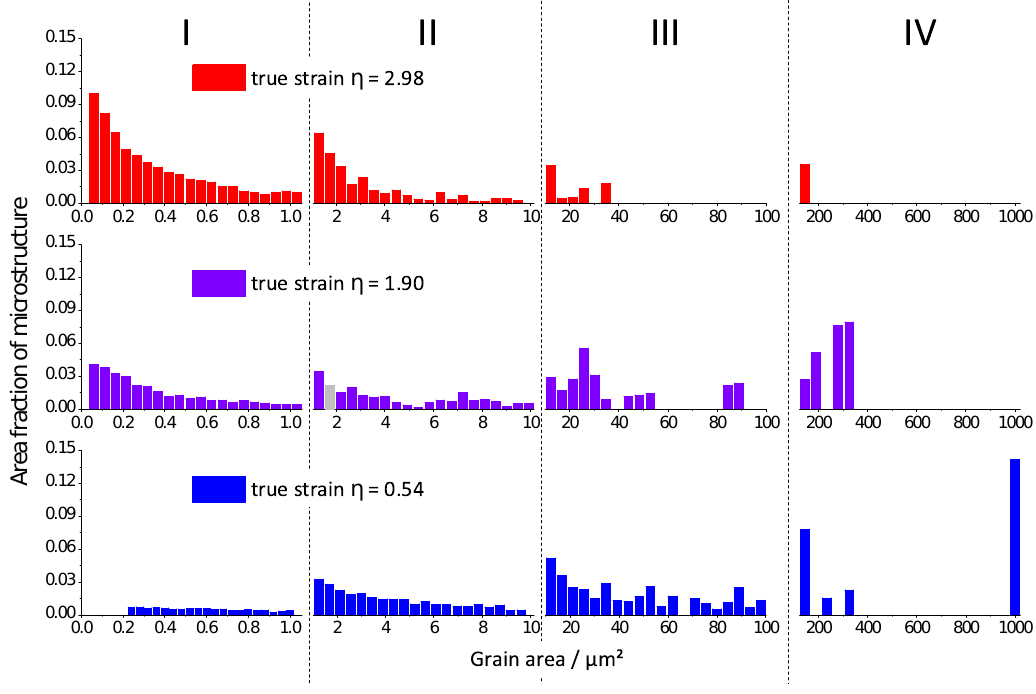
Figure 3. Area fraction of grain size after deformation to a true strain of 0.54, 1.90 and 2.94; I to IV represent classes of grain size for the order 0.04 µm 2 to 45 µm 2